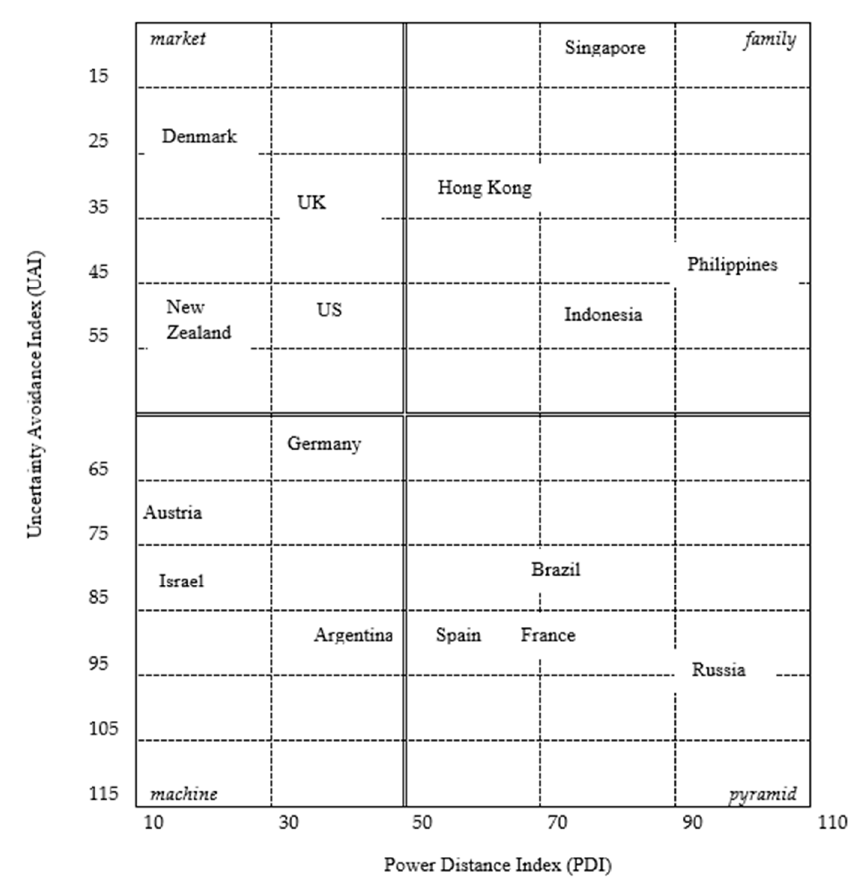
Figure 1. Power distance versus uncertainty avoidance.